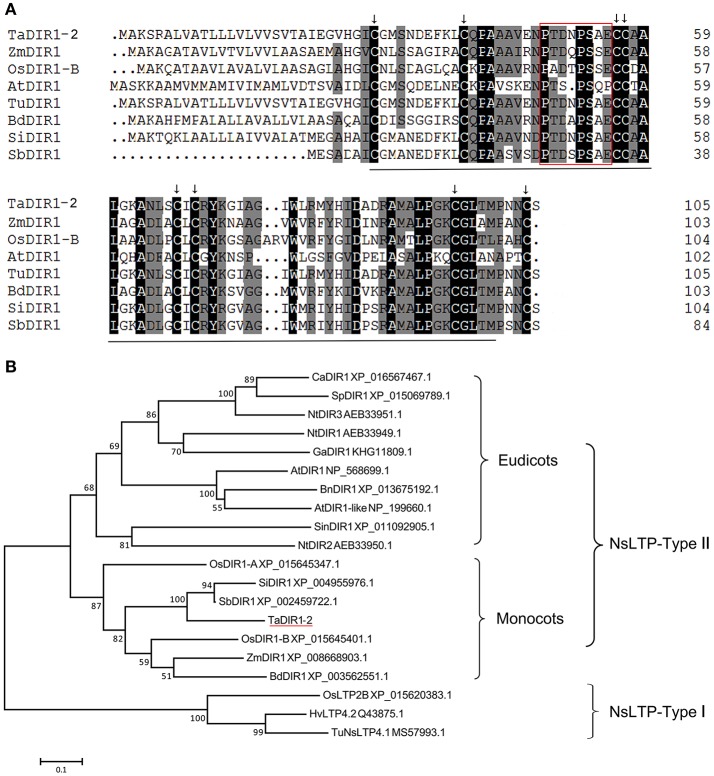
Multiple alignment and phylogenetic analysis of the deduced amino acid sequences of TaDIR1-2 with other DIR1 and lipid transfer proteins (LTPs) from higher plants. (A) Sequence alignment of AtDIR1 and its Orthologs from monocot plants. The black line indicates the nsLTP (Non-specific lipid-transfer protein) domain, the black arrow represents the 8-cysteine signature indicating the LTP type 2 family, and the red box indicates a proline-rich domain. (B) A representative phylogenetic tree of TaDIR1-2 with other DIR1 proteins and LTPs from higher plants. At, Arabidopsis thaliana; Bd, Brachypodium distachyon; Bn, Brassica napus; Ca, Capsicum annuum; Ga, Gossypium arboreum; Hv, Hordeum vulgare subsp. Vulgare; Nt, Nicotiana tabacum; Os, Oryza sativa; Sb, Sorghum bicolor; Si, Setaria italic; Sin, Sesamum indicum; Sp, Solanum pennellii; Ta, Triticum aestivum; Tu, Triticum urartu; Zm, Zea mays. Bootstrap values (>50%) based on 1000 replications are shown at branch nodes. NsLTP-Type-I was used as an out-group. The bar indicates 1 substitution per 10 nucleotide positions.